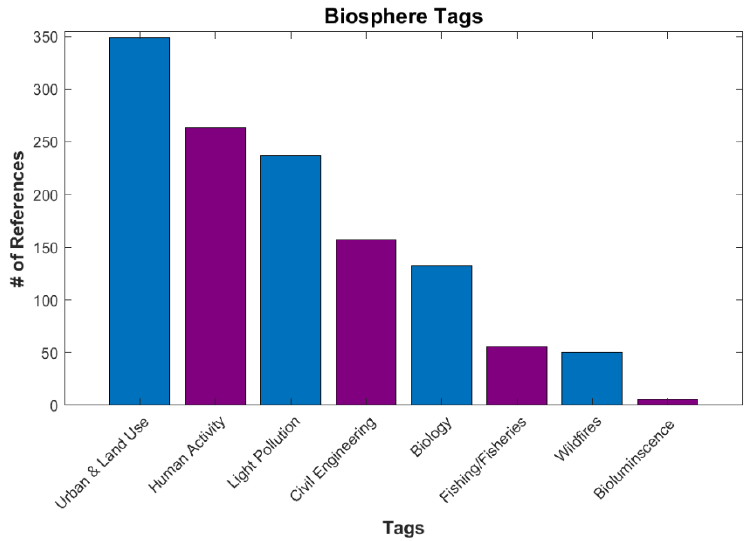
Figure 20. Number of references under Biosphere.